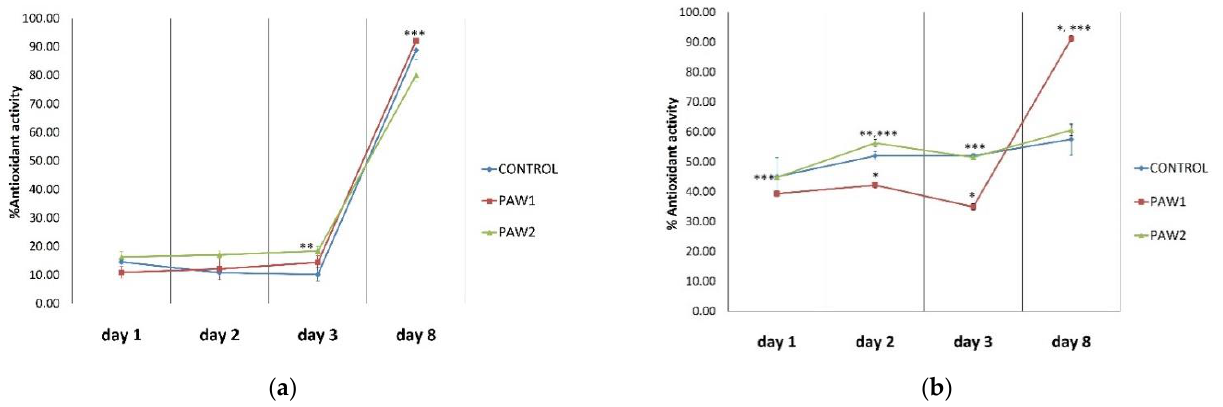
Figure 7. Antioxidant activity of the free ( a ) and bound ( b ) phenolic fractions isolated from Triticum aestivum L. cv. Glosa sprouts (days 1, 2, and 3) and shoots (day 8); * significant difference ( p < 0.05) between control and PAW1; ** significant difference ( p < 0.05) between control and PAW2; *** sig- nificant difference ( p < 0.05) between PAW1 and PAW2. Each point represents the mean ± SD of three determinations.